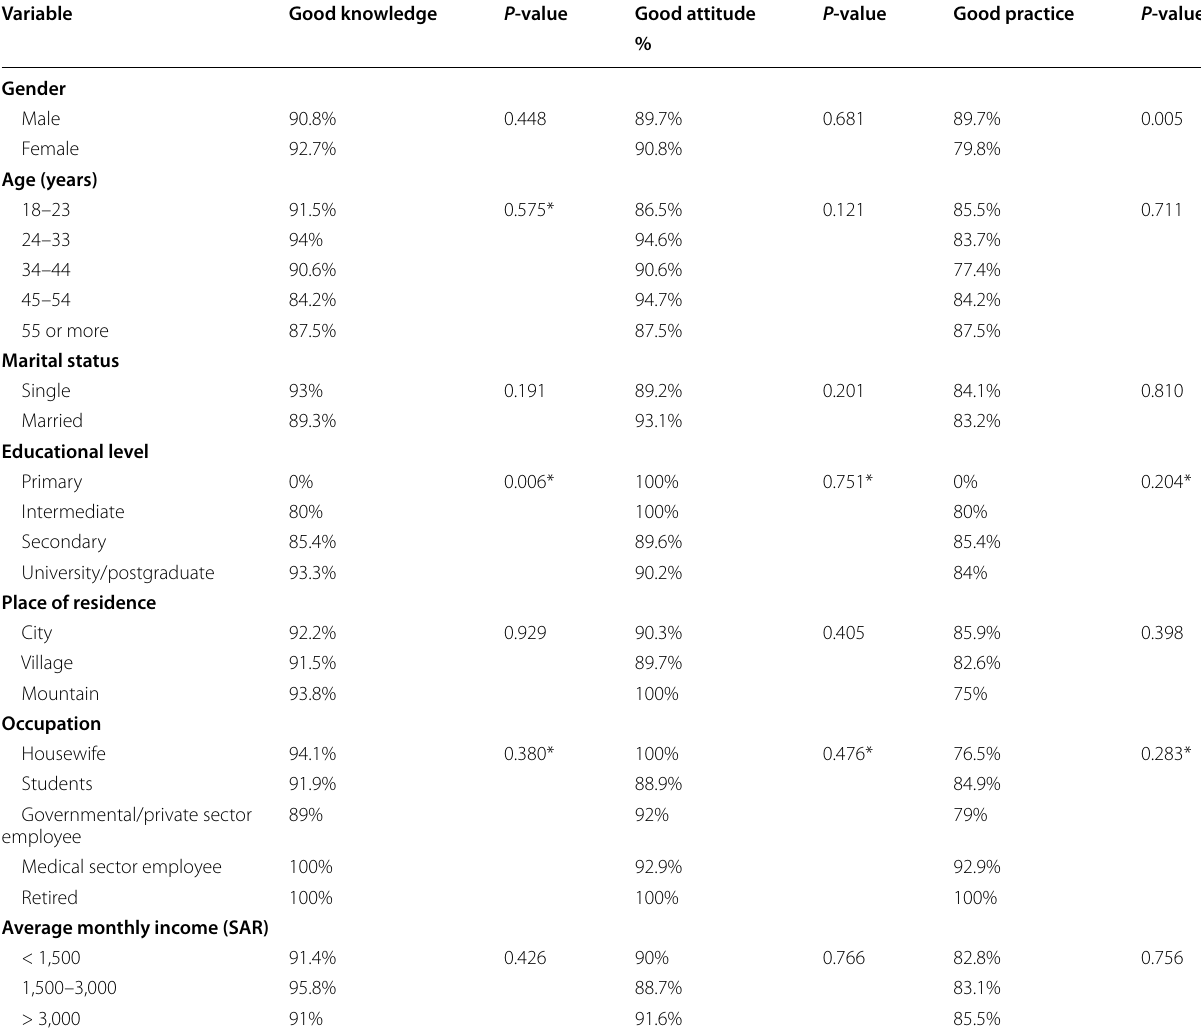
* P -values were calculated using Fisher’s exact